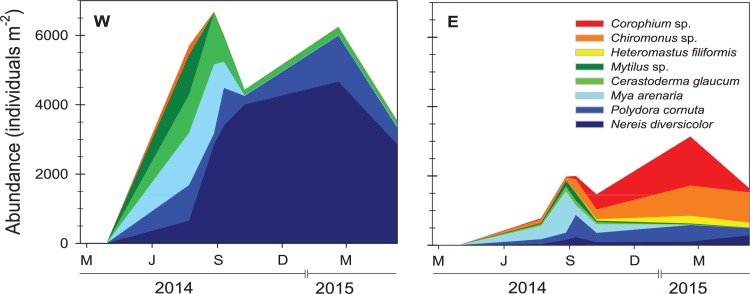
Colonization of benthic infauna at the Western (W) and Eastern (E) stations after flooding of the Gyldensteen Coastal Lagoon.March 29, 2014 is point of origin for all graphs. X-axis tick marks indicate start of March (M), June (J), September (S) and December (D).